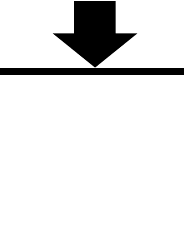
Figure 6. Casted reference specimen (REF) with independent load direction (black arrow) due to non-existent layering [28].